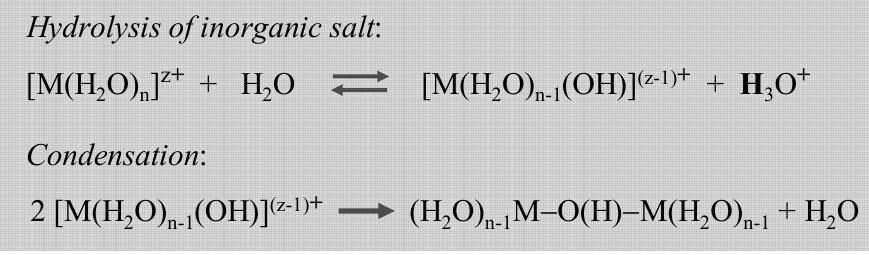
Figure 4. Gelation processes of inorganic metal